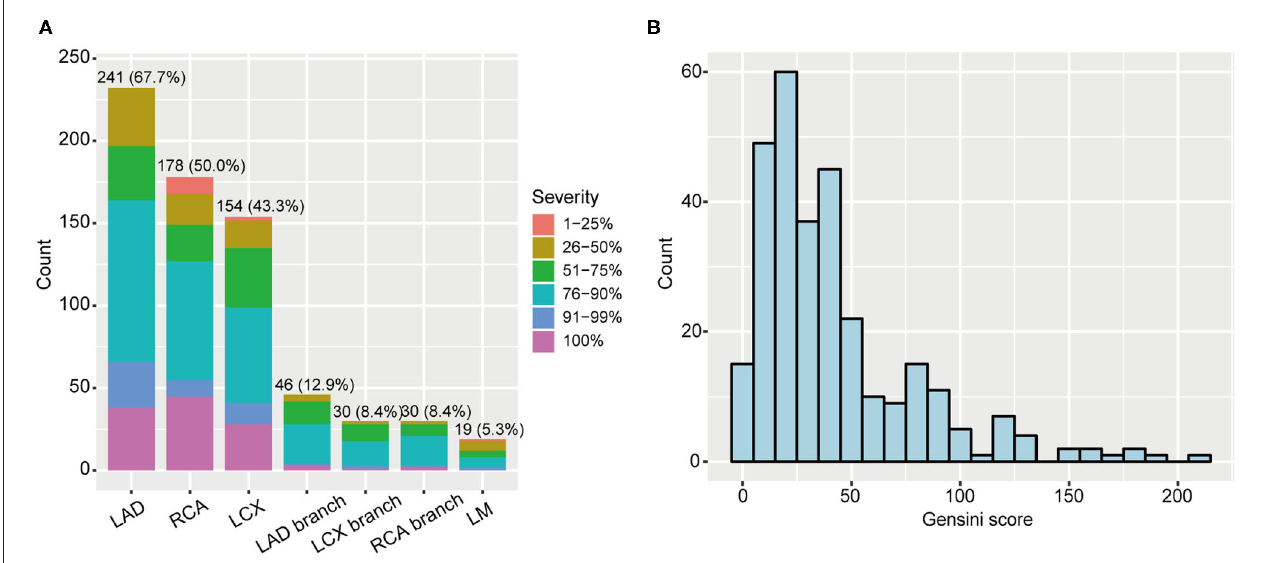
FIGURE 1 | Coronary artery stenosis severity of 356 CAD patients. (A) Distribution of stenosis severity and locations. (B) Gensini score distribution in CAD patients. CAD, coronary artery disease; LAD, left anterior descending artery; RCA, right coronary artery; LCX, left circumflex artery; LM, left main.